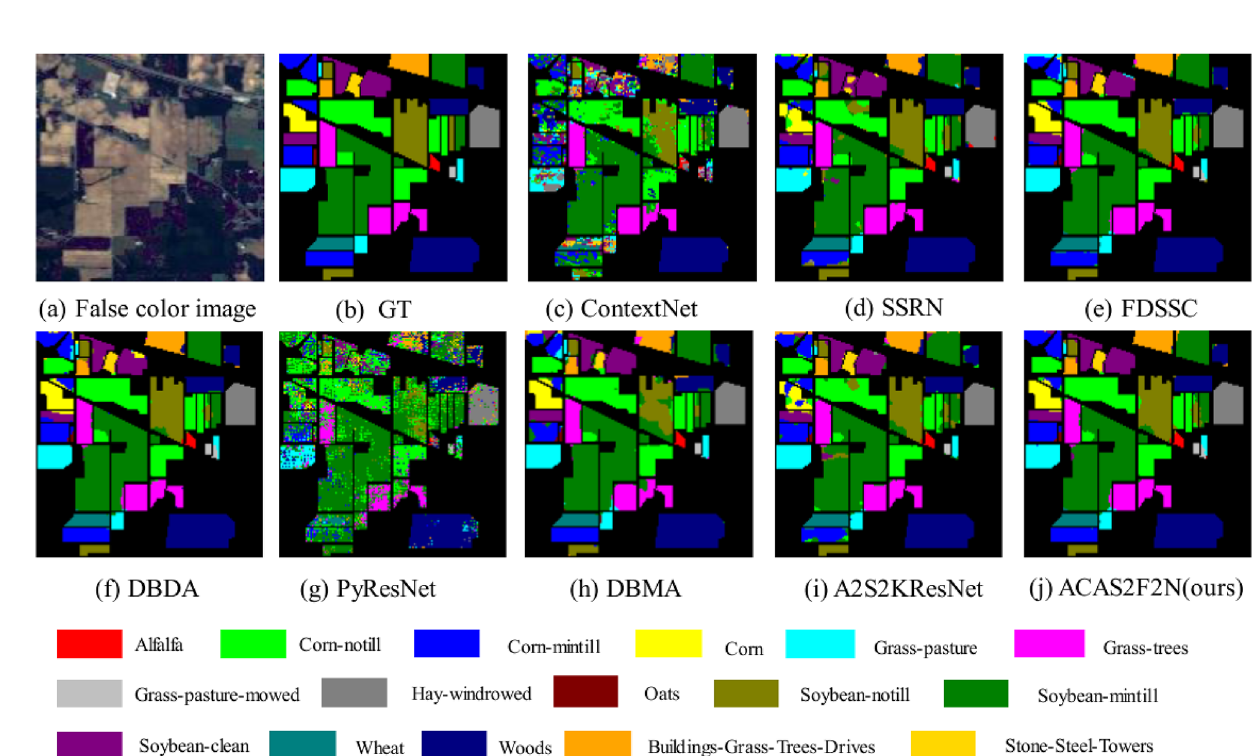
Figure 5. Hyperspectral classification maps on IP. ( a ) False color image. ( b ) Ground truth. ( c – i ) Performance of all baselines. ( j ) Performance of the proposed ACAS2F2N. The other content is color and label